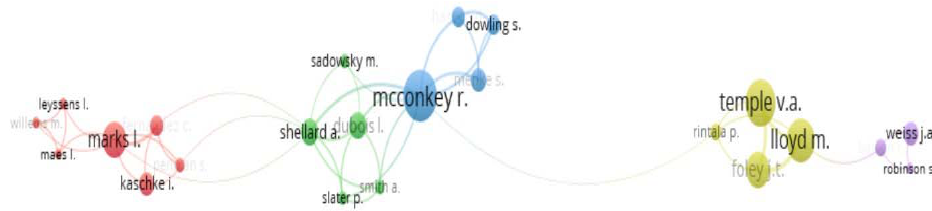
Figure 2. Authors network.